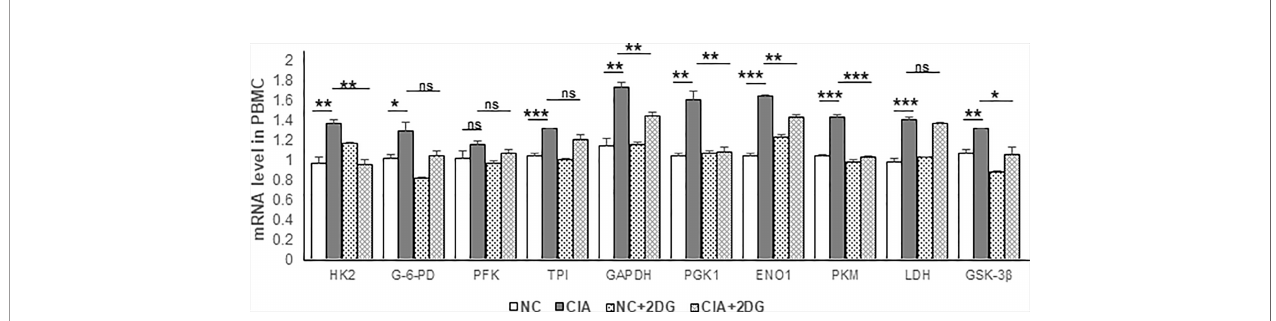
FIGURE 4 | The effect of 2-DG treatment on the mRNA expression of glycolytic enzymes in PBMCs of CIA rats. The CIA rats were treated with PBS (n=6) or 2-DG (n=6). The healthy rats (NC) treated with PBS (n=6) or 2-DG (n=6) were used as controls. The mRNA levels were determined using quantitative real-time PCR. *p < 0.05, **p < 0.01, ***p < 0.001, ns, not signi fi